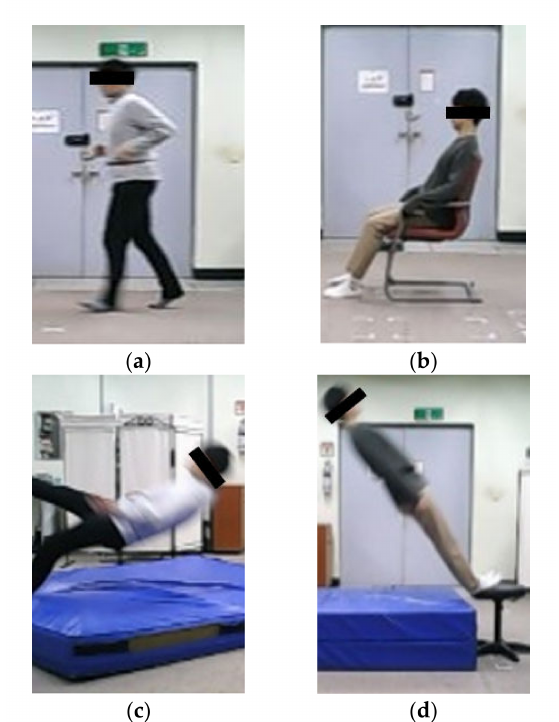
Figure 4. ADLs and fall motions: ( a ) Jogging, ( b ) Quickly sitting on the chair and getting up, ( c ) Slip-backward fall and ( d ) Backward